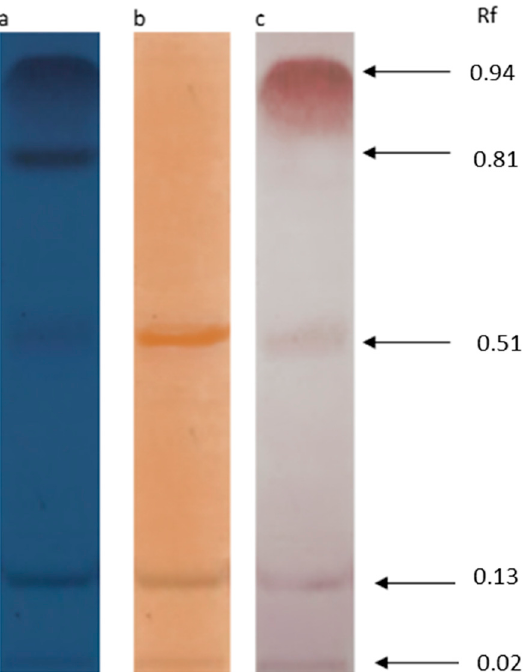
Figure 2. TLC analysis of the lipopeptides produced by the B. mojavensis P1709 strain (spots re- vealed: ( a ) by UV light; ( b ) after iodine vapor staining; ( c ) after ninhydrin staining). ( a ) by UV light; ( b ) after iodine vapor staining; ( c ) after ninhydrin